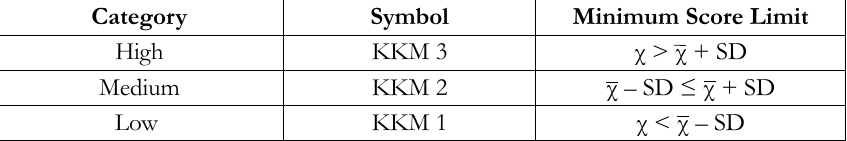
Table 3. Criteria for the Categorization of the Mathematic connection